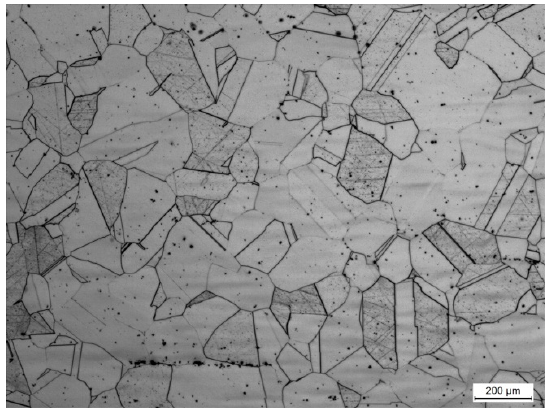
Figure 1. The microstructure of as-received Fe-20Mn-4Al-0.3C steel after soaking at 1200 °C for 2 h.